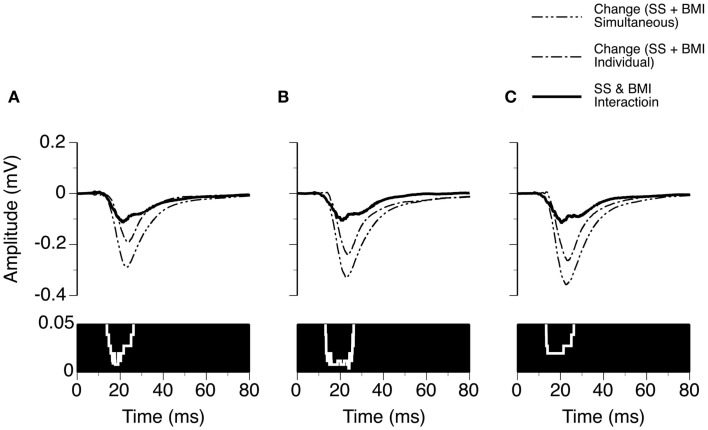
Group results (n = 9) showing time windows over which a synergistic interaction exists between SS and BMI in enhancing the amplitude of an LFP recorded at the BF of a recording site. (A–C) are based on results obtained at 10, 20, and 30 dB above the MT of a recording site. In (A–C), a white line with a black background in the bottom panel is a p-value by time function showing statistical significance of the difference between the total changes caused by individual and simultaneous applications of SS and BMI.